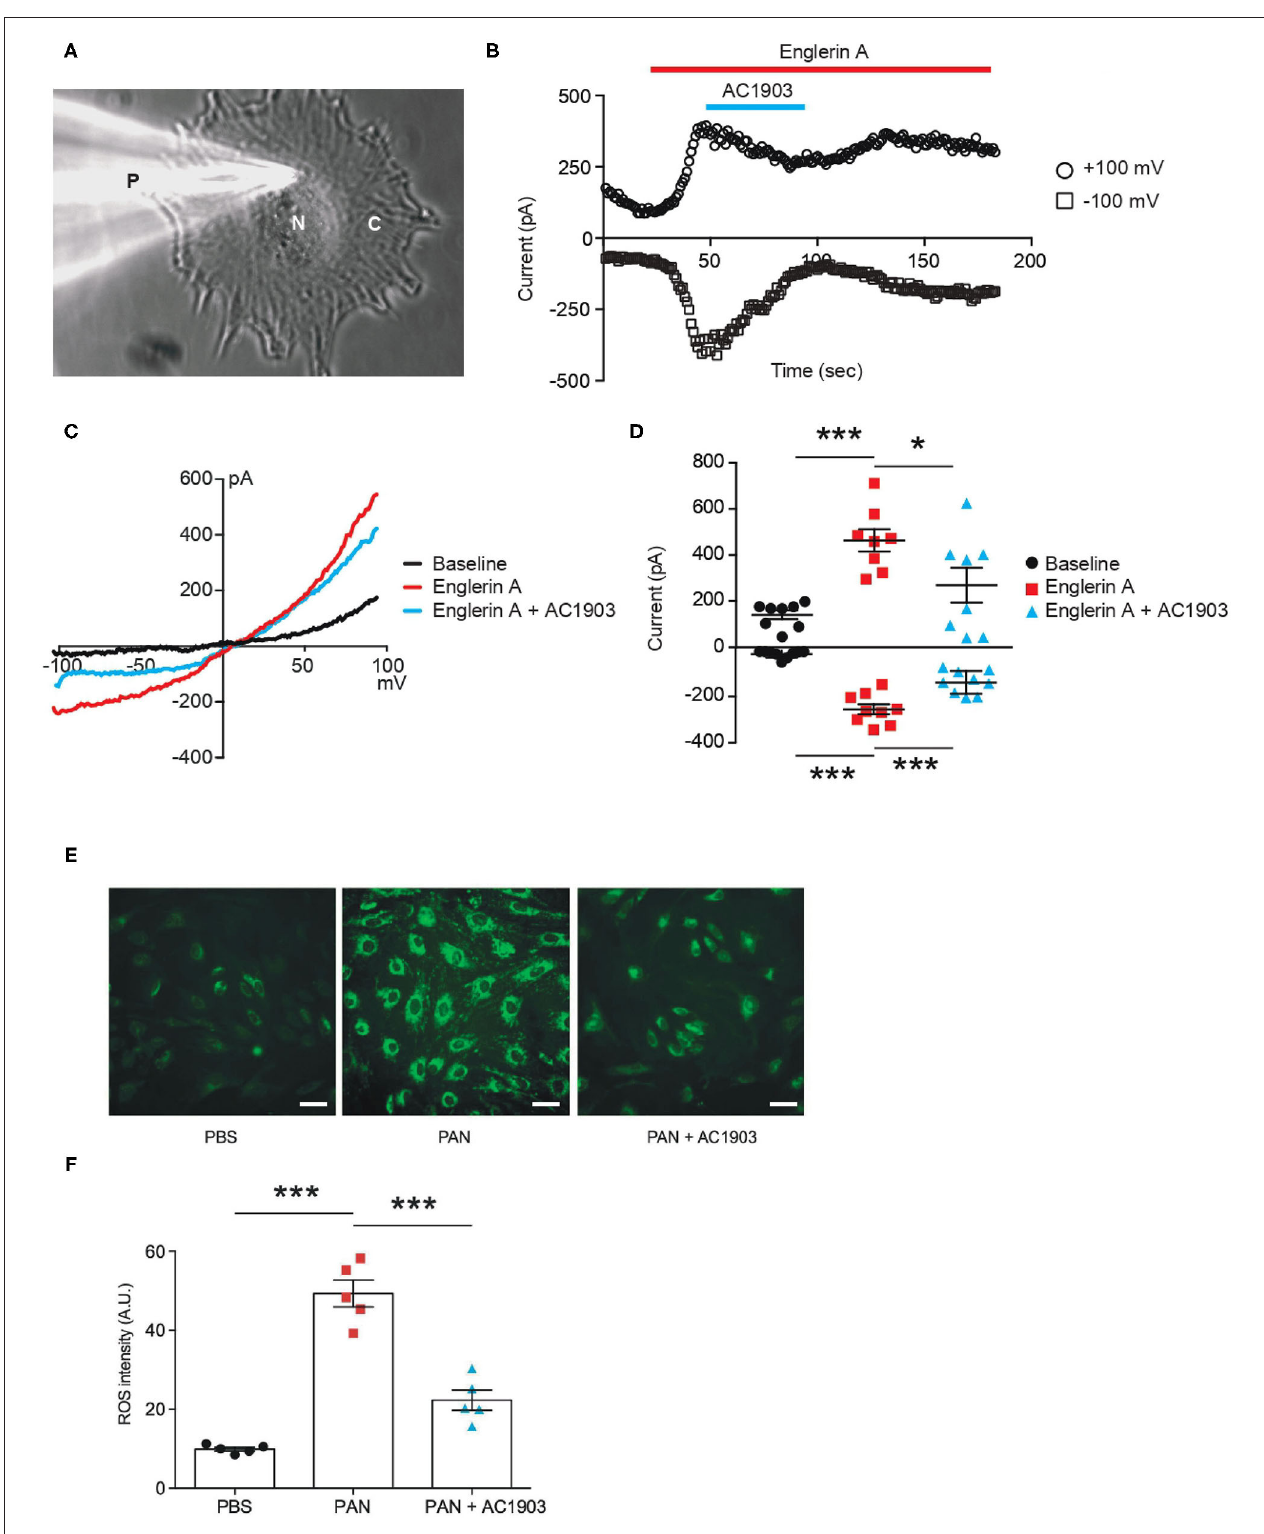
FIGURE 3 | Functional TRPC5 channel activity blocked by AC1903 reduces cytosolic ROS and protects cytoskeletal proteins in PAN-treated iPodos. (A) Representative image of a human iPodo patch clamp recording in the whole-cell configuration. P, Glass pipette; N, iPodo nuclear; C, iPodo cytosol. (B)